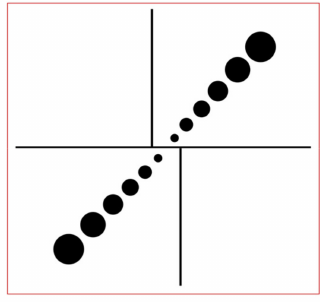
Figure 7. The new calibration